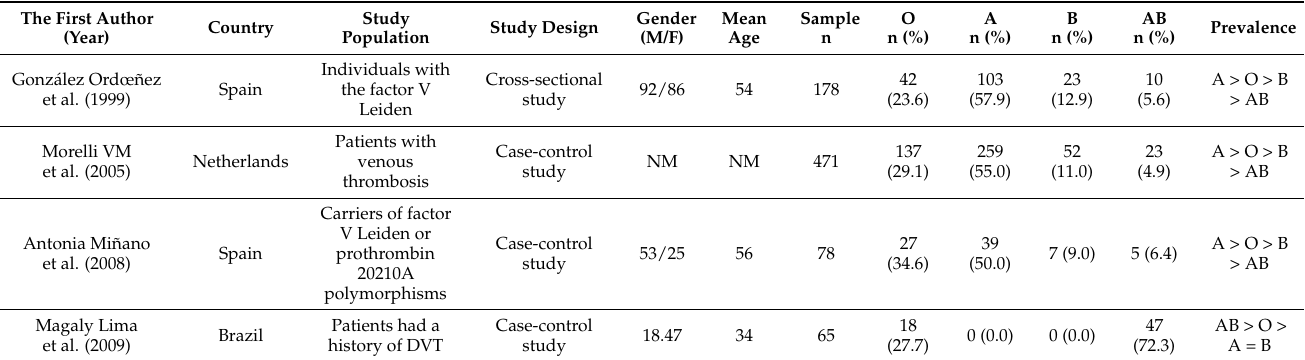
Table 1. The primary feature of the included studies